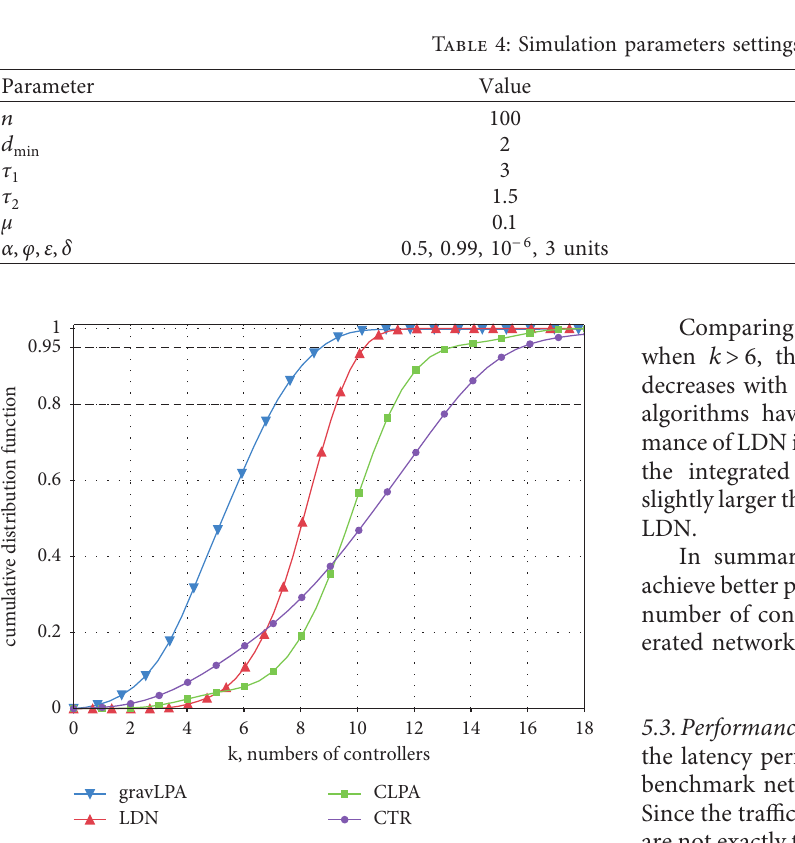
Figure 6: The cumulative distribution function curve of con- trollers’ number without k